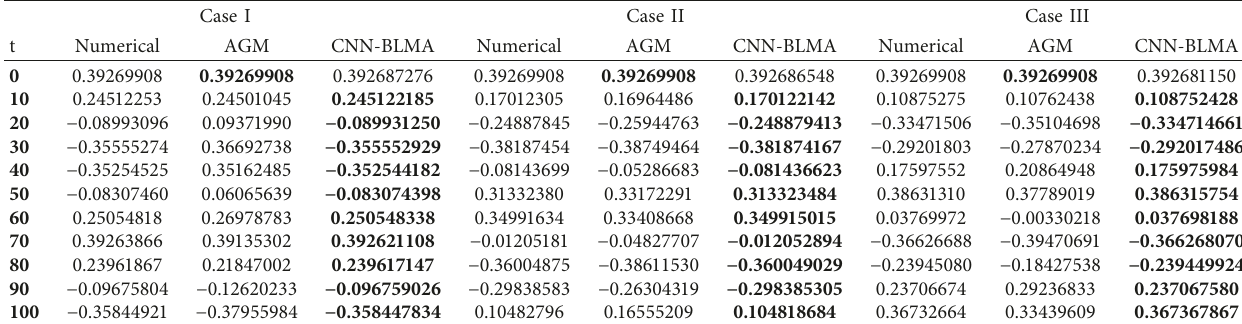
Figure 3: Influence of variations in R and α on an angular displacement of a circular sector. Table 2: Comparison of approximate solutions obtained by the proposed algorithm for the influence of variations in α with R � 15 on an angular displacement of a homogenous circular